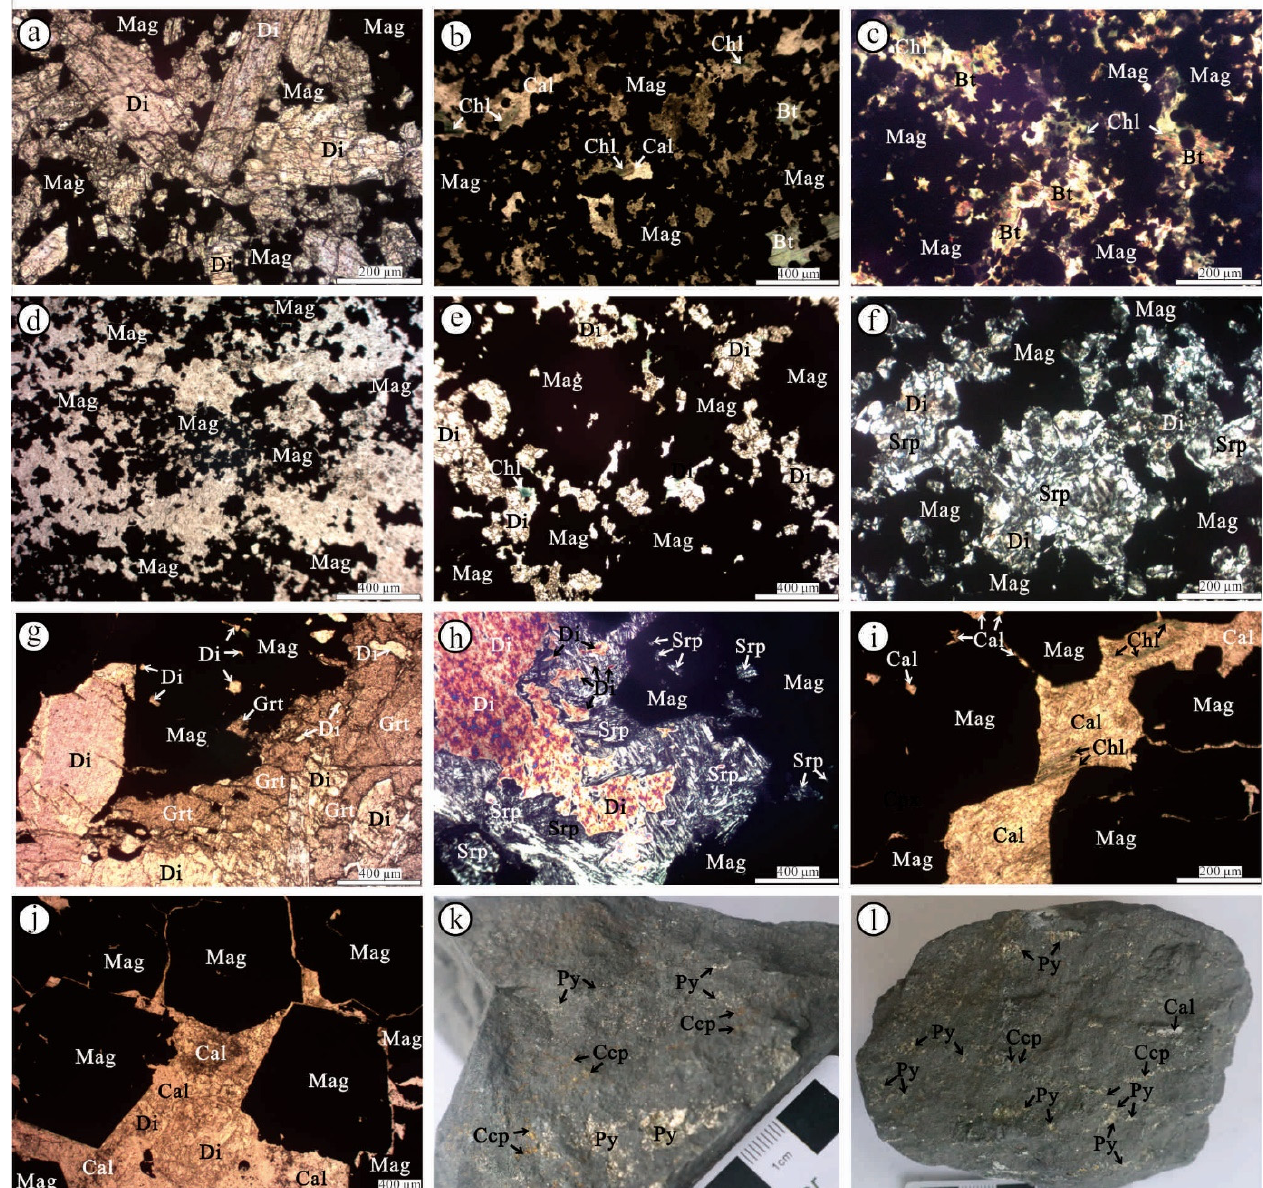
Figure 6. Various types of iron ore and characteristics of wall rocks in the Jinling iron skarn deposit. ( a ) Disseminated magnetite that is interstitial to early euhedral diopside. ( b , c ) Massive magnetite crystals coexisted with biotite and chlorite. ( d ) Banded magnetite. ( e ) Banded magnetite that has enclosed an early anhedral crystal of diopside that was metasomatized. ( f ) Massive magnetite crystals coexisted with fibrous serpentine that has completely replaced early diopside. ( g ) Metasomatic texture formed between early subhedral–euhedral diopside, garnet, and late massive magnetite. ( h ) The residual metasomatic texture between diopside and fibrous serpentine coexisted with massive magnetite. ( i , j ) Late calcite has partially replaced euhedral massive magnetite. ( k , l ) Euhedral pyrite and chalcopyrite veins in iron ore. Photos ( a , b , d , e , g , i , j ) were taken under open polarizers and ( c , f , h ) taken under crossed polarizers. Abbreviations: Bt = biotite, Cal = calcite, Chl = chlorite, Ccp = chalcopyrite, Di = diopside, Grt = garnet, Mag = magnetite, Py = pyrite, Srp =